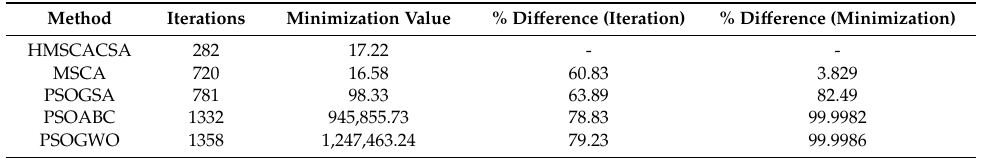
Figure 6. Convergence curves of mathematical functions for ( a ) F1, ( b ) F2, ( c ) F3, ( d ) F4, ( e ) F5 and ( f ) F7 using the MSCA, HMSCACSA, PSOGSA, PSOGWO, and PSOABC. Table 3. Percentage di ff erences between our proposed method (HMSCACSA) and other metaheuristics (MSCA, PSOGSA, PSOABC, and PSOGWO; results also presented in Figure 6).